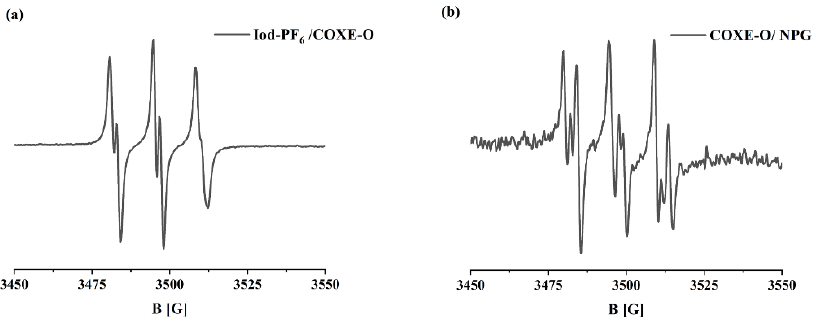
Figure 12. ESR spectra for radicals generated by ( a ) Iod-PF 6 /COXE-O, ( b ) COXE-O/NPG upon ex- posure to LED irradiation at 400 nm trapped by PBN in tert -butylbenzene within 10 min.